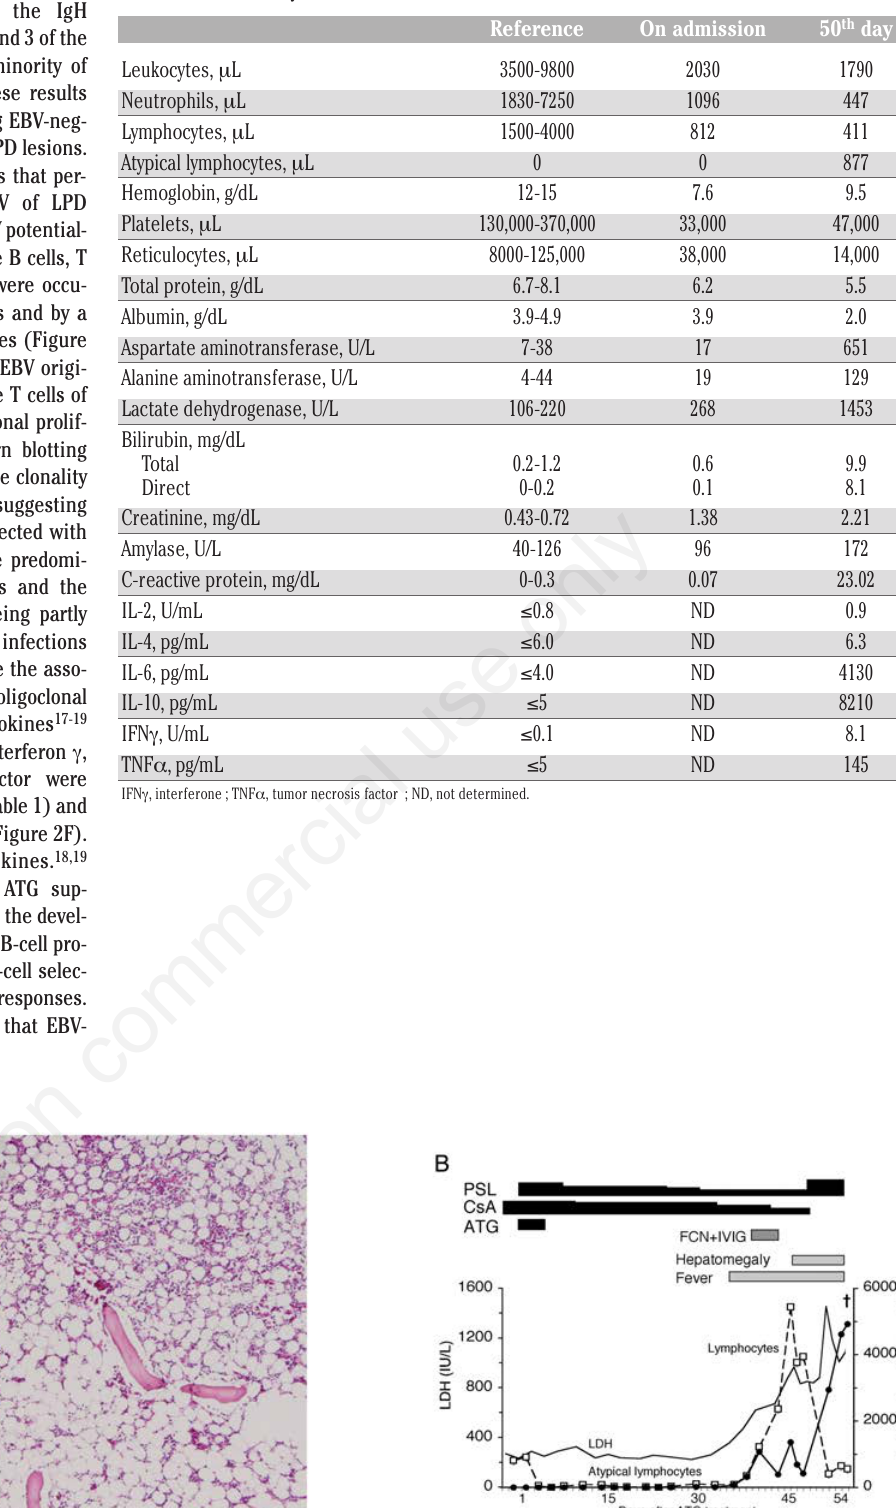
Table 1. Laboratory data.